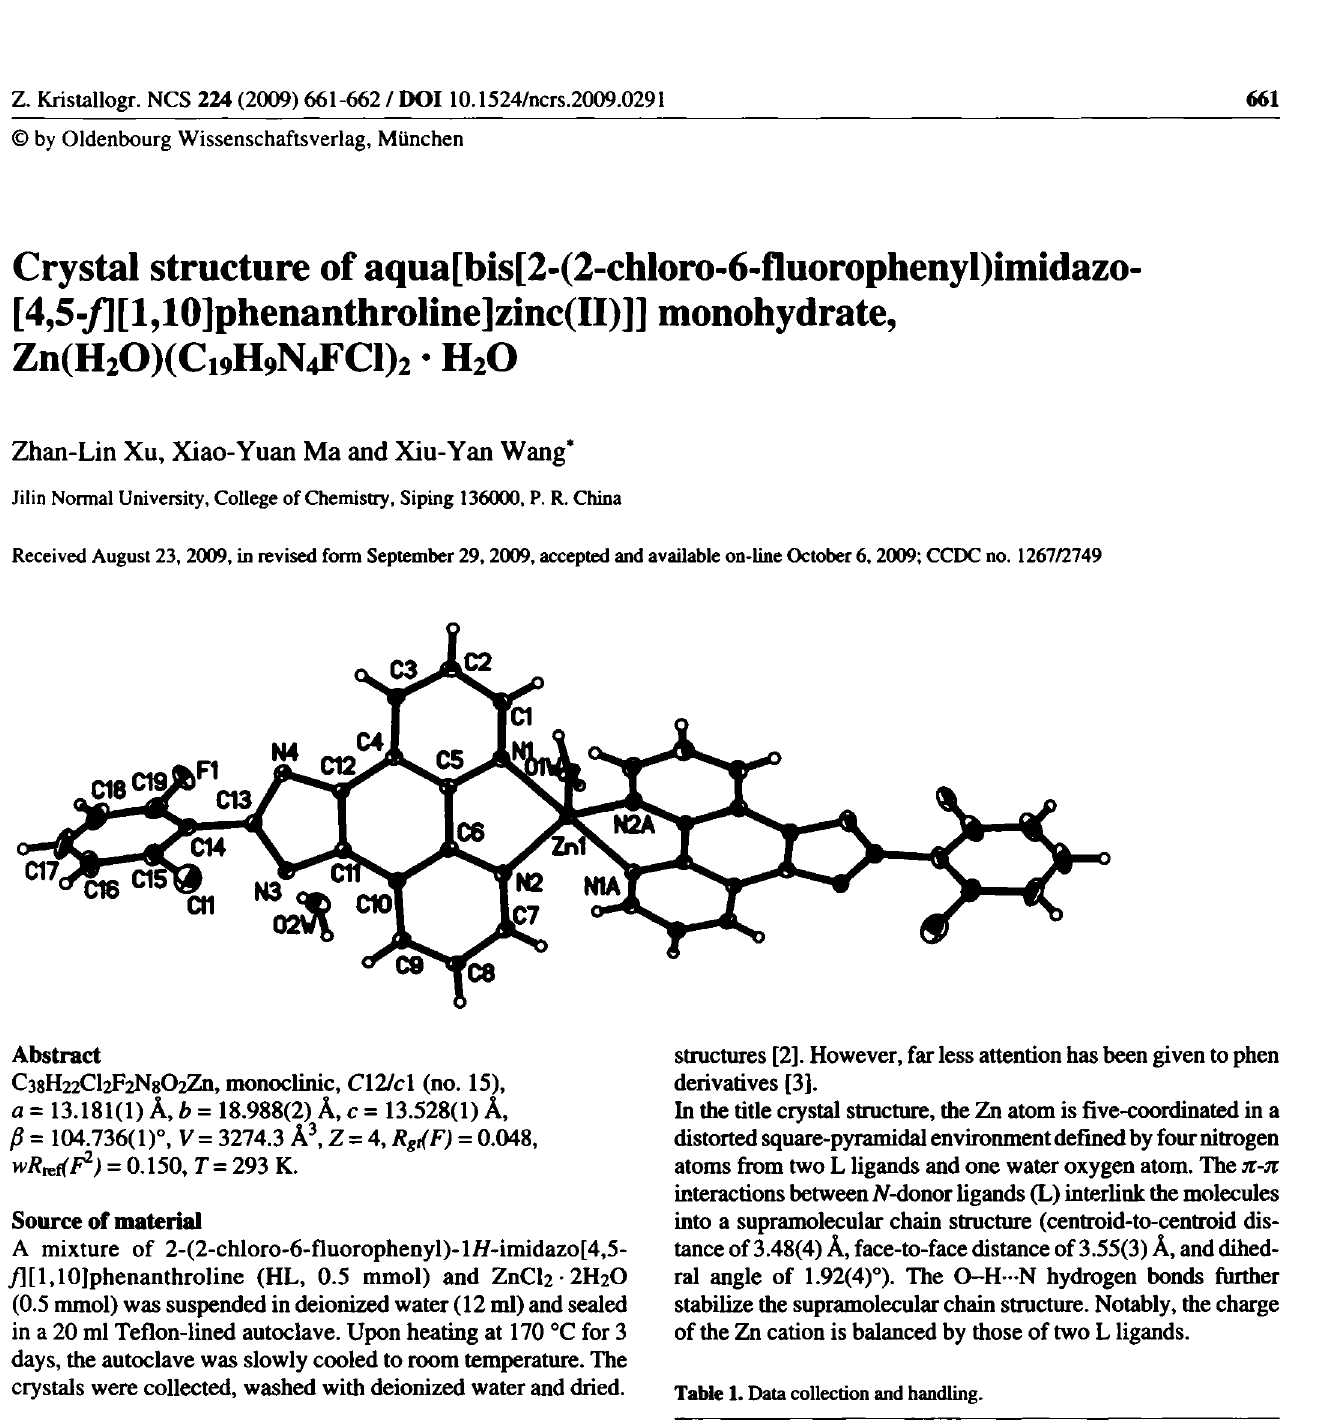
Table i. Data collection and handling. Crystal: